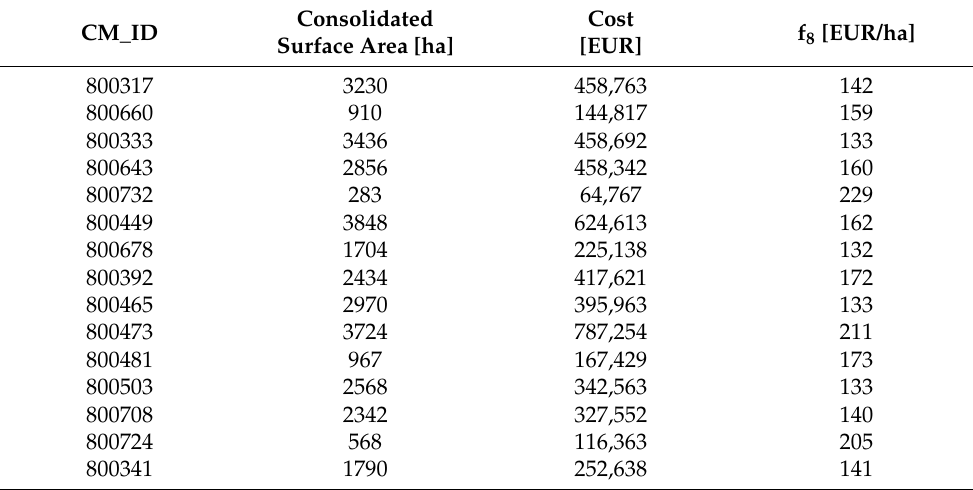
Table 4. Review of the total costs of realization of land consolidation